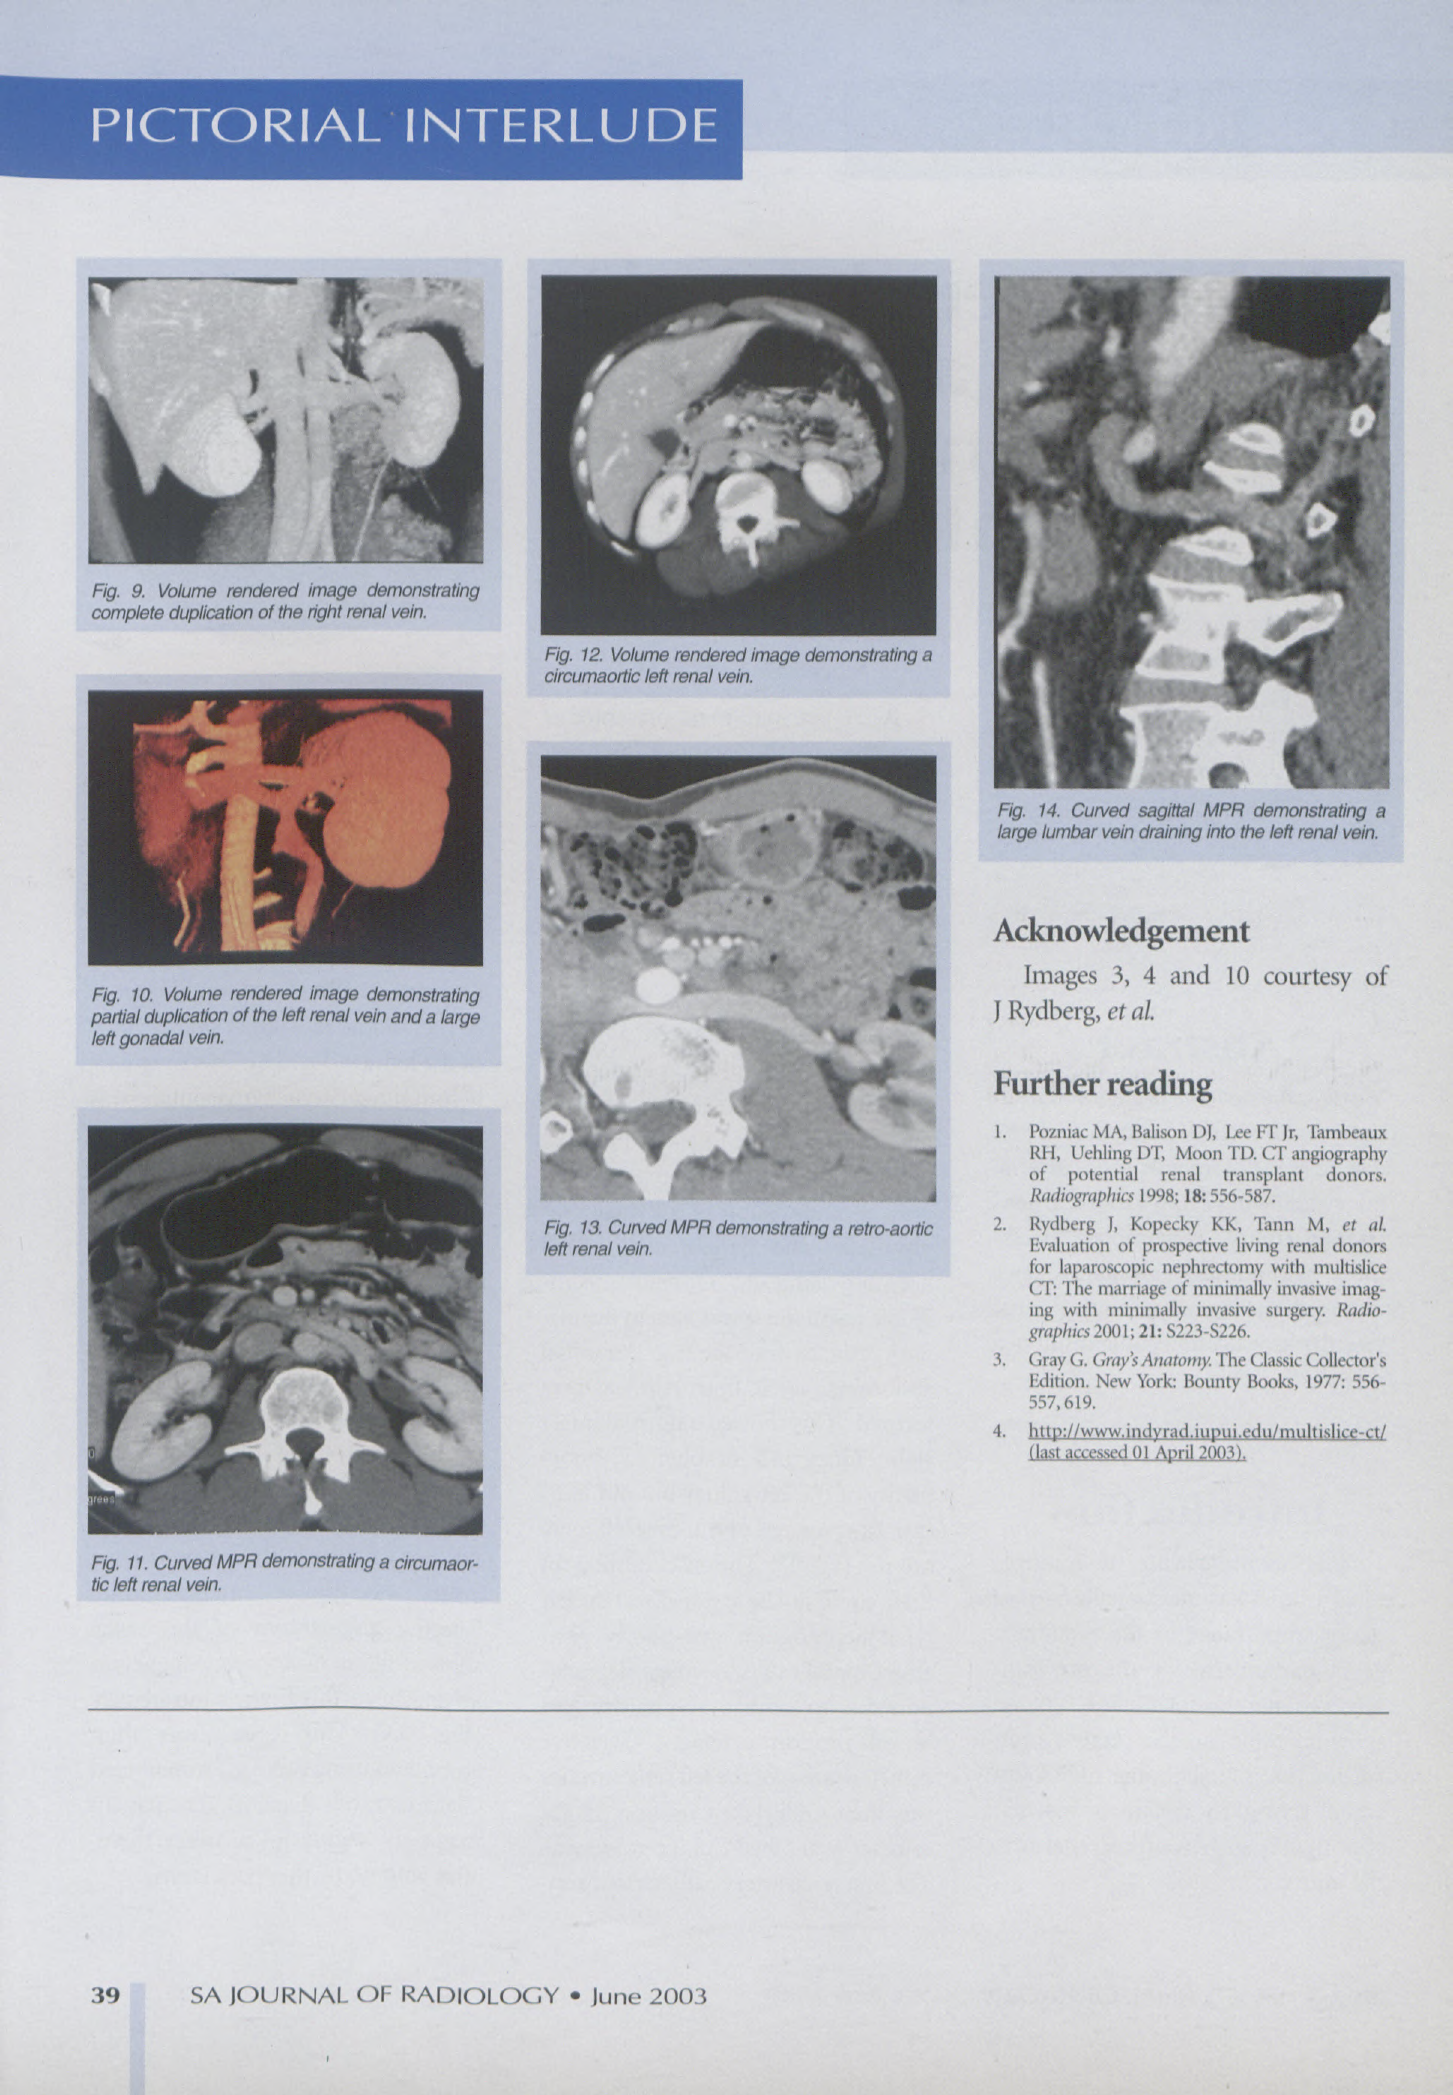
Fig. 9. Volume rendered image demonstrating complete duplication of the right renal vein.